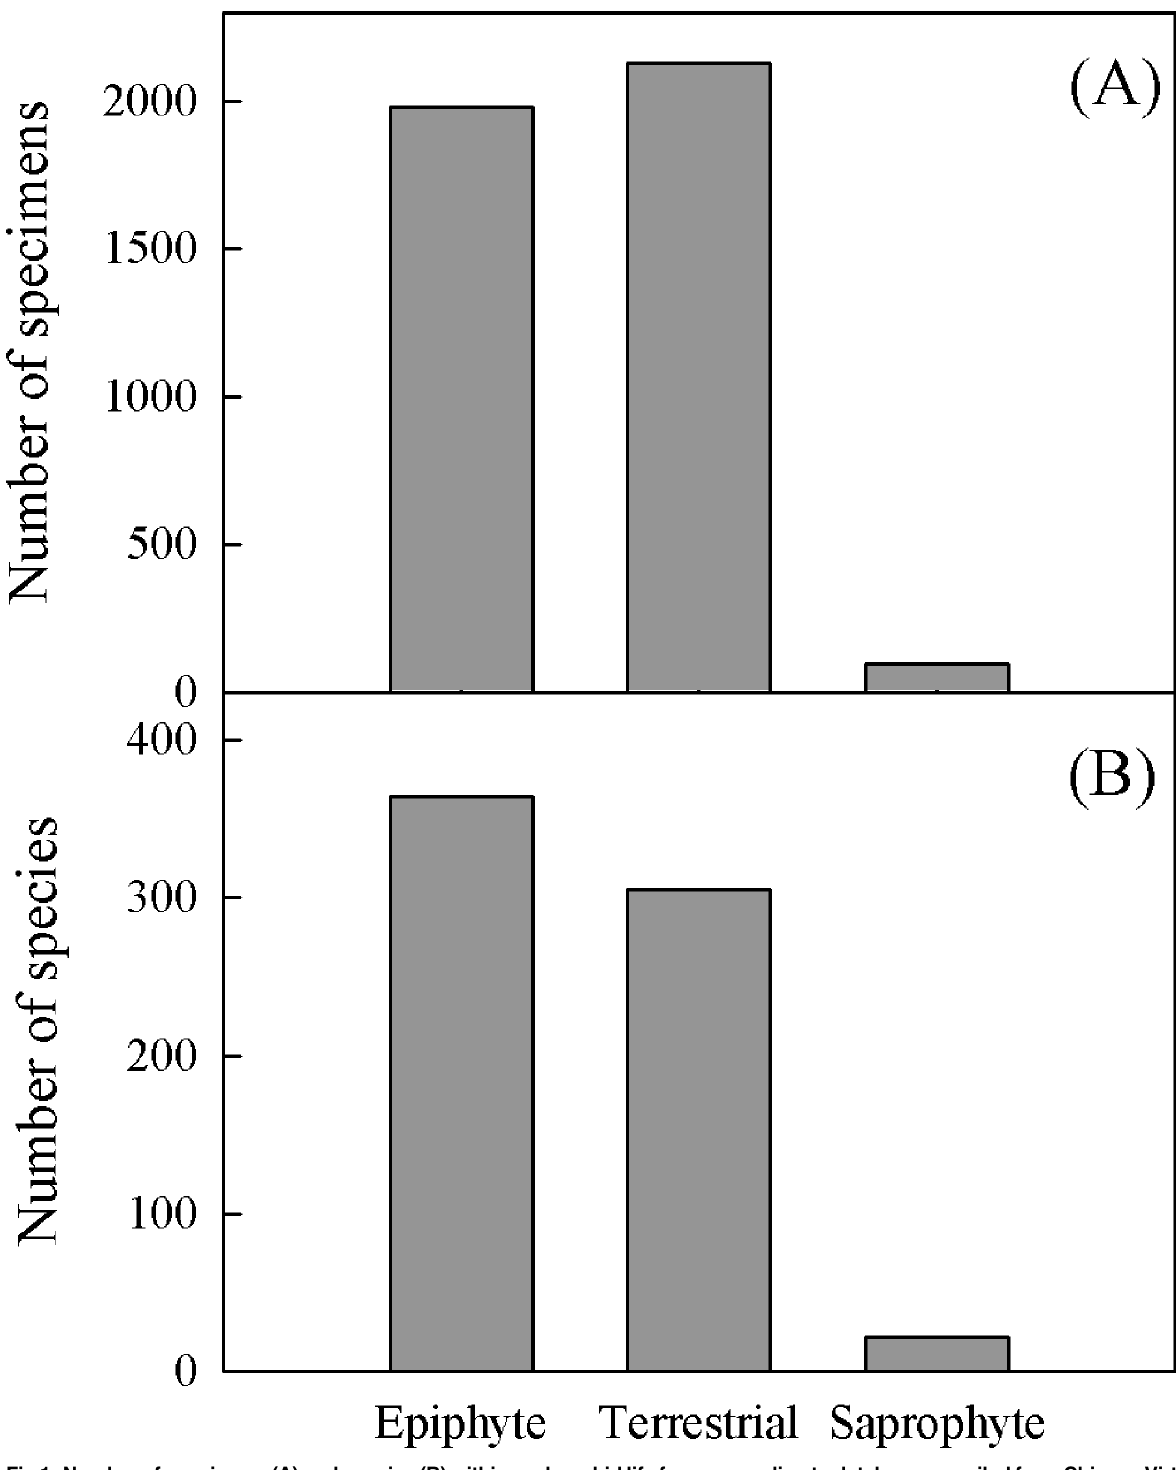
Fig 1. Number of specimens (A) and species (B) within each orchid life form, according to database compiled from Chinese Virtual Herbarium.